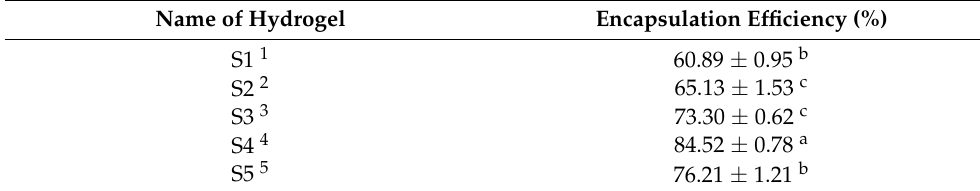
Table 1. Encapsulation efficiency of hydrogels.